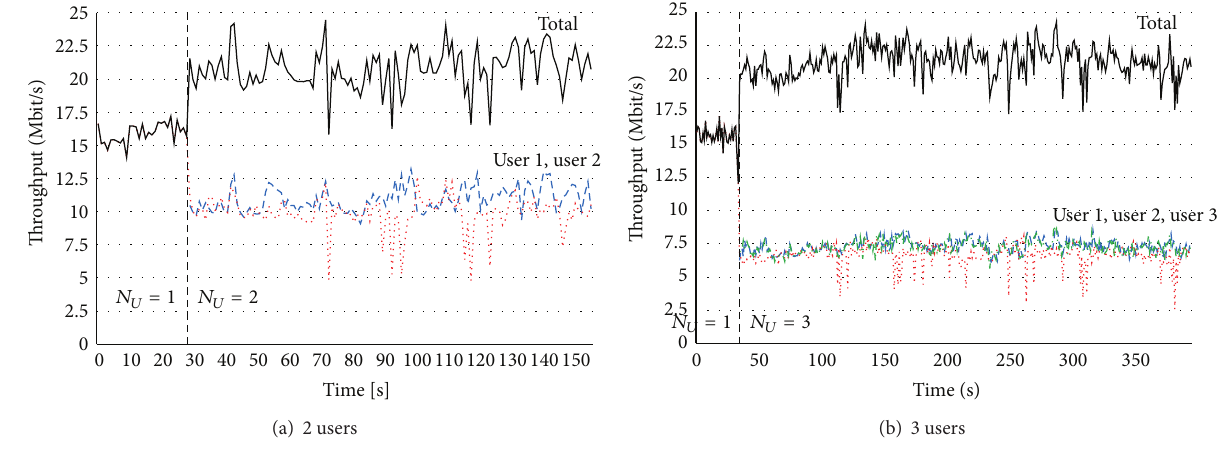
Figure 6: Basic throughput performance with Matrix A/B